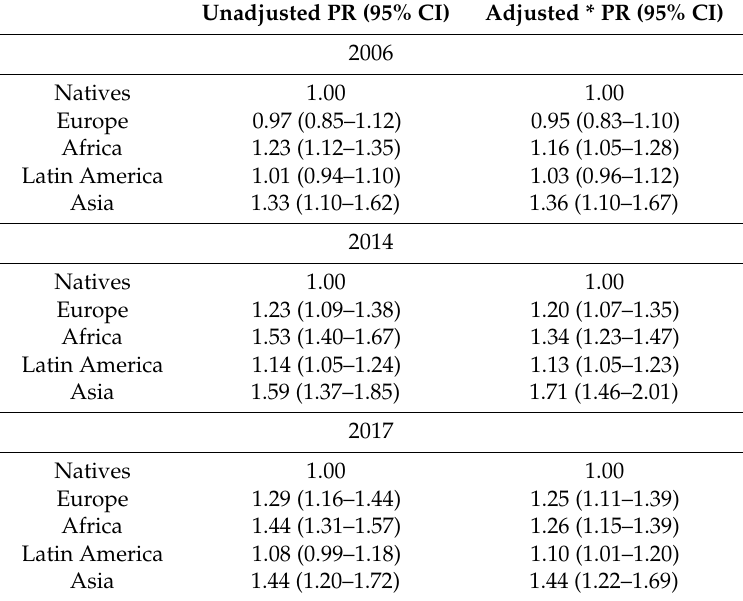
Table 3. Prevalence Ratios and their 95% confidence intervals of non-use of dental care in the last year for place of birth by year of the survey: Spanish National Health 2006 and 2017 and European Health Survey in Spain